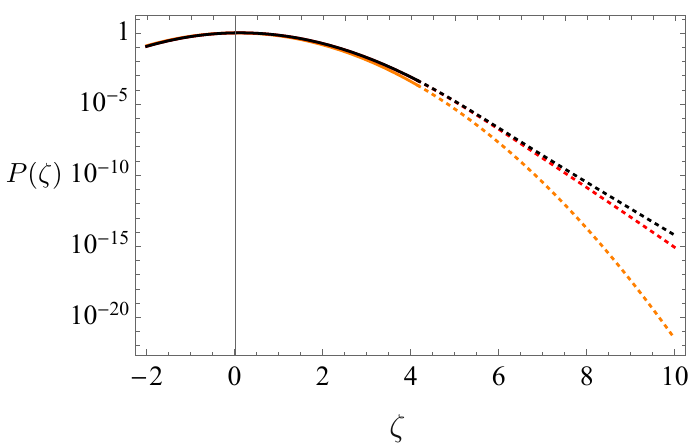
Figure 4 . We plot the log of the ζ distribution given by (4.53) for three different values of g . The black line corresponds to λ = 0 , the red line to λ = 10 − 5 and the orange line to λ = 10 − 2 . The dotted lines are the regions where 3 ζ > Ht µ 2 Ω 2